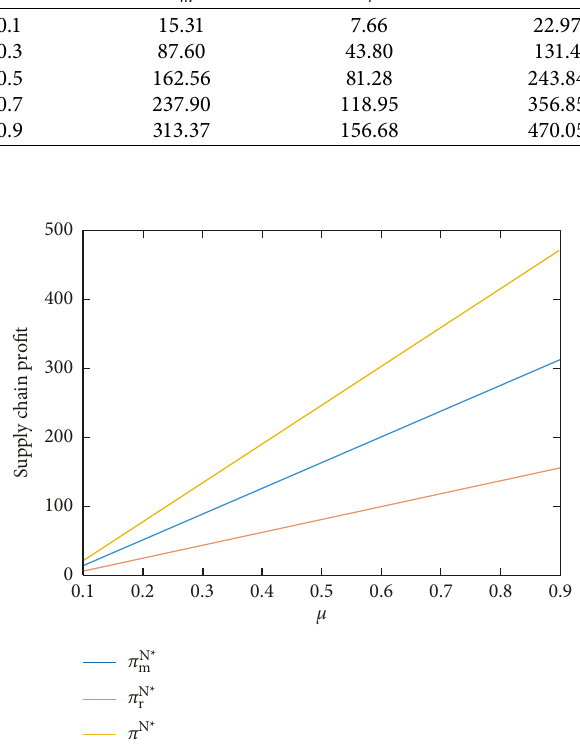
Figure 2: The impact of the genuine product rate μ on the profit of the supply chain.